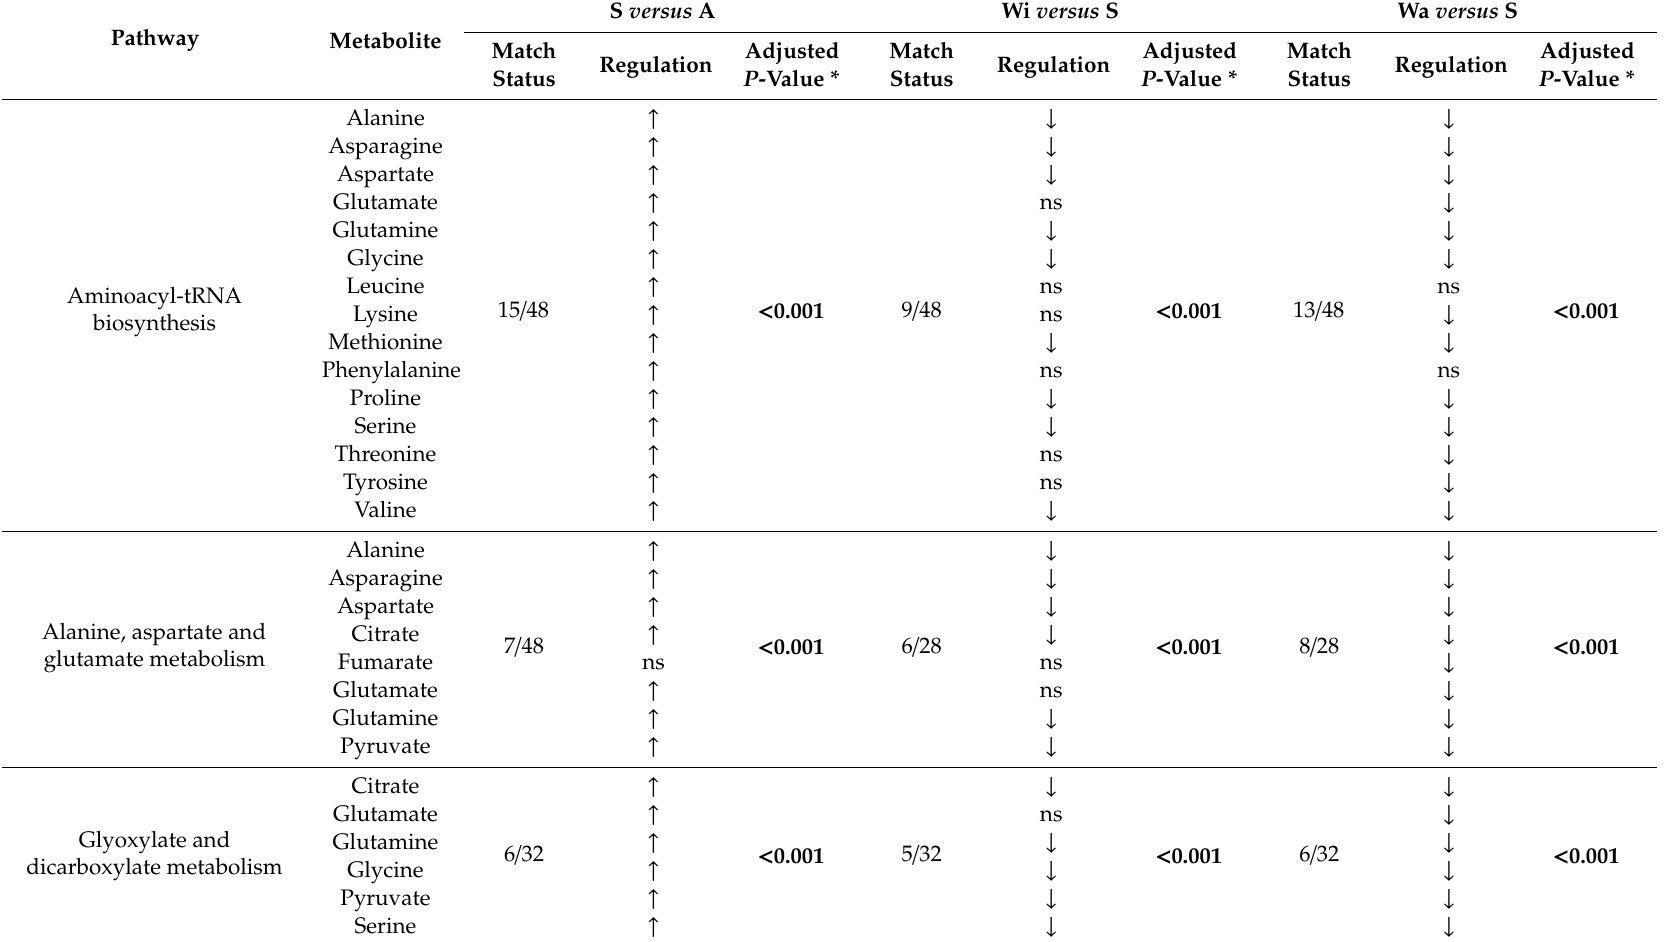
Table 3. Metabolic pathways identified in adult, ageing and ageing Walker 256 tumour-bearing